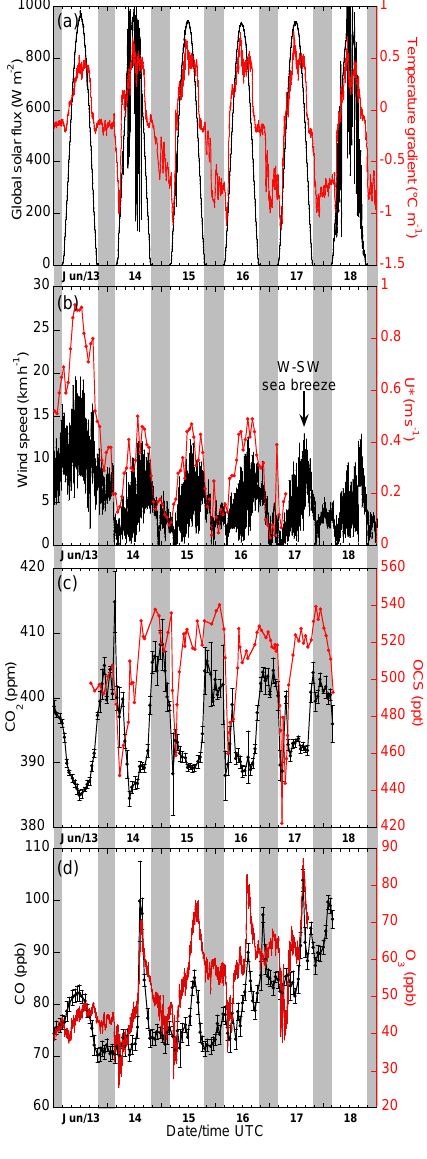
Figure 2. Time series of ambient mixing ratios of OCS, CO 2 , CO, and O 3 at an oak forest ecosystem in southern France (O3HP, June 2012; c, d ) at 2m above ground level, with incoming global radiation and thermal stratification above ground level ( (cid:49)T/(cid:49)H in ◦ Cm − 1 ; a ) and wind speed (b) . Periods of low atmospheric tur- bulence were evaluated using friction velocities ( u ∗ <0.15ms − 1 , b ).The timescale is UTC time and the grey vertical bands corre- spond to nighttime.